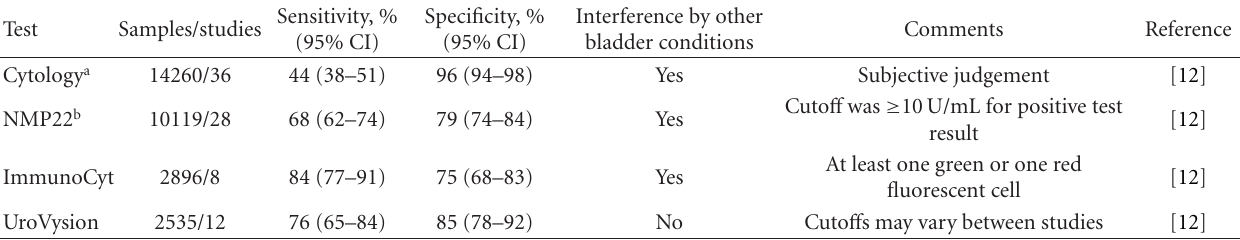
Table 1: Sensitivity and specificity of cytology, NMP22, ImmunoCyt, and UroVysion when no distinguishment is made between patients with suspicion of bladder cancer and patients previously diagnosed with bladder